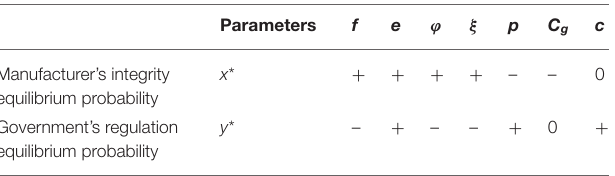
FIGURE 2 | Game members’ equilibrium probabilities as a function of f